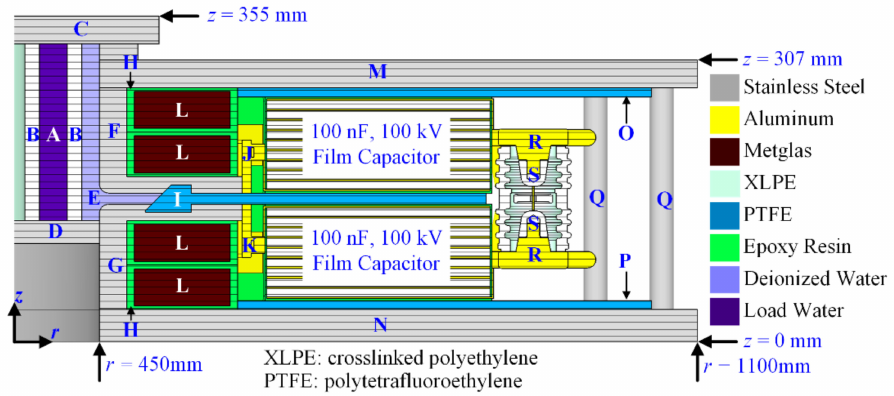
Figure 2. Cross-sectional view ( r - z plane in cylindrical coordinate system) of the newly developed single-stage FLTD. A: load cavity filled with water solution, B: insulating barrier of the load, C: load cavity top lid, D: load cavity bottom lid, E: deionized water-filled cavity, F: negative output electrode, G: positive output electrode, H: epoxy resin casings for magnetic cores, I: middle insulator, J: negative capacitor mounting bracket, K: positive capacitor mounting bracket, L: four separate rings of the magnetic core, M: top lid of FLTD cavity, N: bottom lid of FLTD cavity, O: top insulator, P: bottom insulator, Q: separate columns (24 in total), R: switch terminals, S: switch